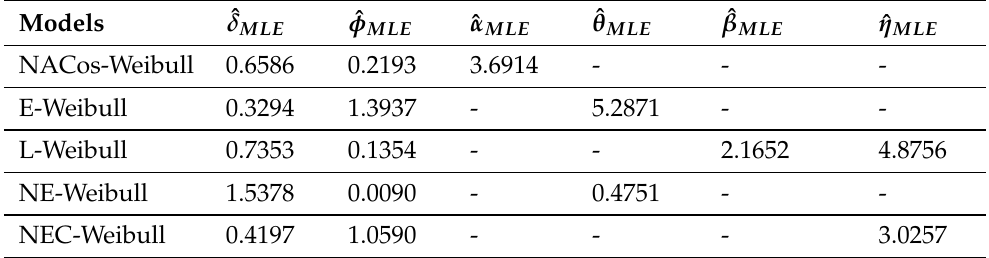
Table 8. Using the failure times data set, the values of ˆ δ MLE , ˆ φ MLE , ˆ α MLE , ˆ θ MLE , ˆ β MLE , and ˆ η MLE of the fitted distributions.